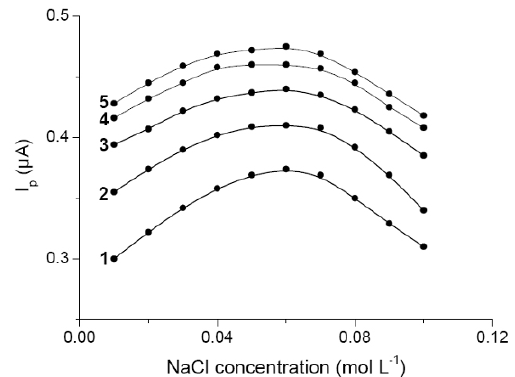
Figure 2. Influence of NaCl concentration on the Hg(II) peak current obtained in DPASV at different HClO Hg(II) concentration: 19.6 μg L -1 . HClO (mol L -1 ): 0.3 (1); 0.5 (2); 1.0 (3); 1.5 (4); 2.0 (5). Experimental conditions: see section